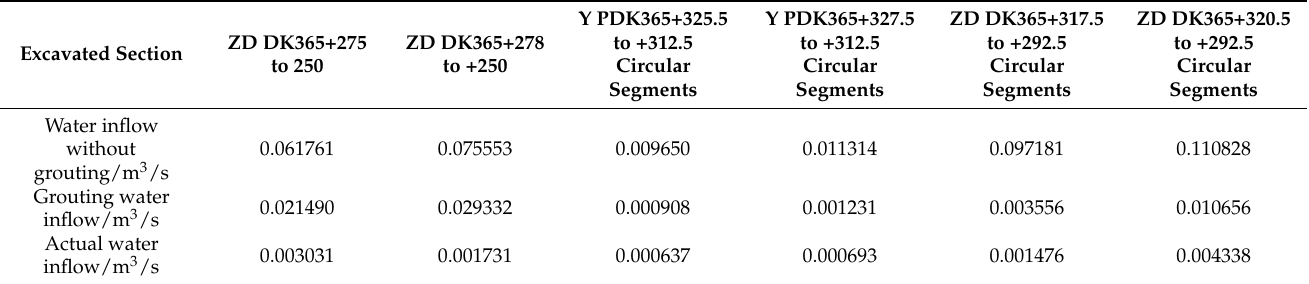
Table 27. Different excavation sections before and after the slurry injection of water influx and measured value